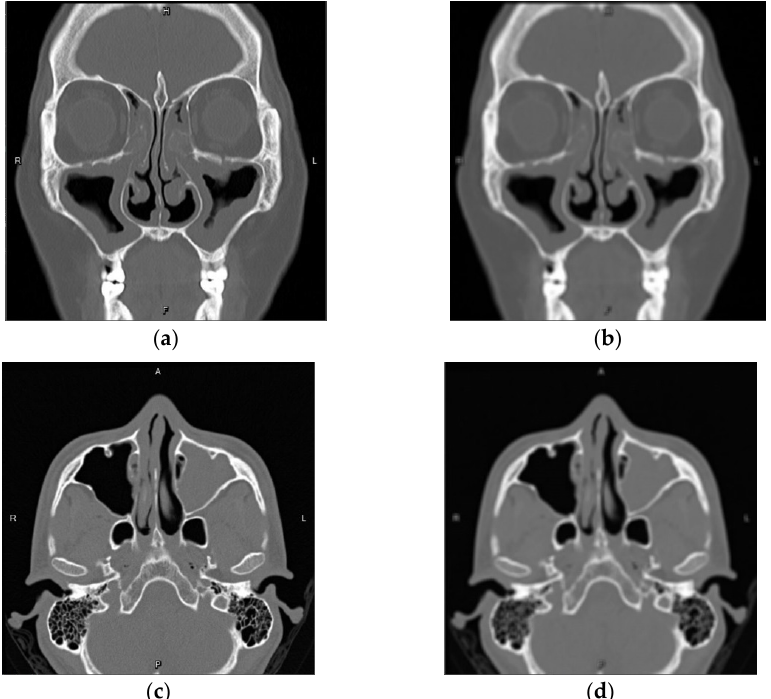
Figure 11. Resulting images after Gaussian blur. ( a ) Original image; ( b ) Gaussian blurred image; ( c ) Original image; ( d ) Gaussian blurred image.